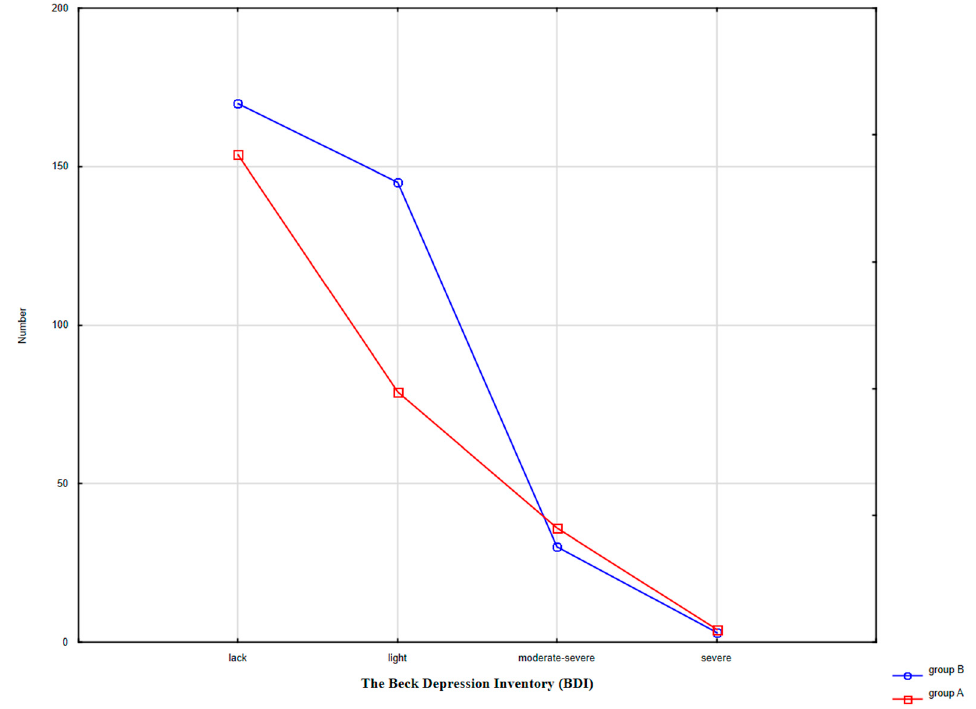
Figure 2. Interaction of the density of clinical symptoms of depression based on BDI (The Beck Depression Inventoty).